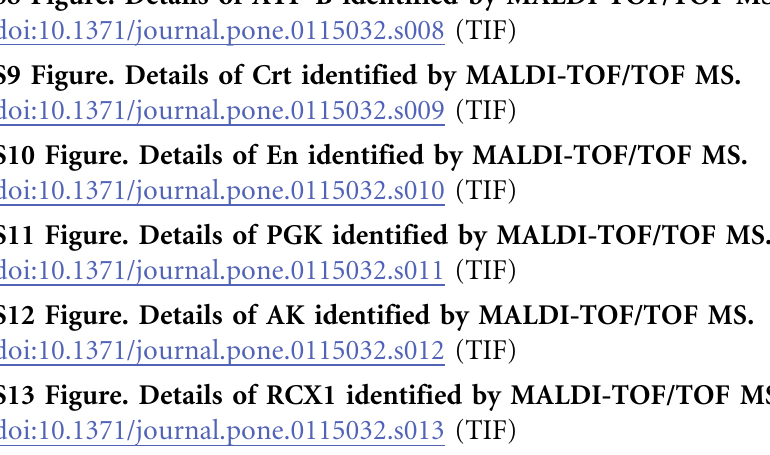
S1 Figure. Details of ATP-A (band) identified by MALDI-TOF/TOF MS. S2 Figure. Details of Actin identified by MALDI-TOF/TOF MS. S3 Figure. Details of RP0 identified by MALDI-TOF/TOF MS. S4 Figure. Details of PHB2 identified by MALDI-TOF/TOF MS. S5 Figure. Details of GDAP identified by MALDI-TOF/TOF MS. S6 Figure. Details of ATP-A (spot) identified by MALDI-TOF/TOF MS. S7 Figure. Details of HSP60 identified by MALDI-TOF/TOF MS. S8 Figure. Details of ATP-B identified by MALDI-TOF/TOF MS. S9 Figure. Details of Crt identified by MALDI-TOF/TOF MS. S10 Figure. Details of En identified by MALDI-TOF/TOF MS. S11 Figure. Details of PGK identified by MALDI-TOF/TOF MS. S12 Figure. Details of AK identified by MALDI-TOF/TOF MS. S13 Figure. Details of RCX1 identified by MALDI-TOF/TOF